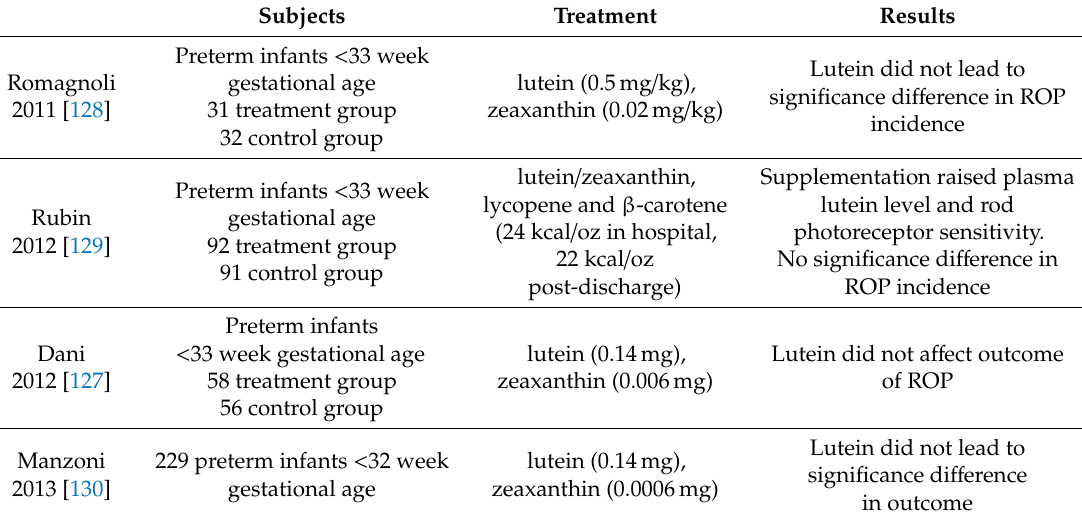
Table 9. Studies showing the association between lutein supplementation and Retinopathy of prematurity (ROP)